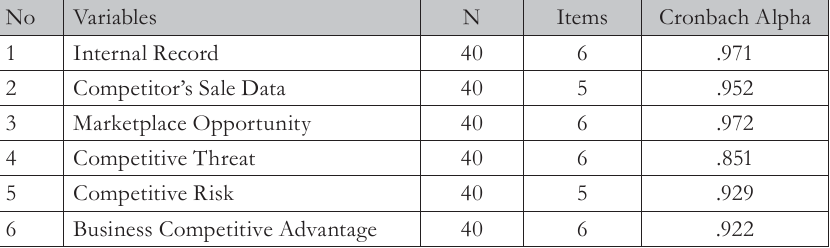
Tab. 1 - Reliability Test of Variables (Source: Pilot Study,